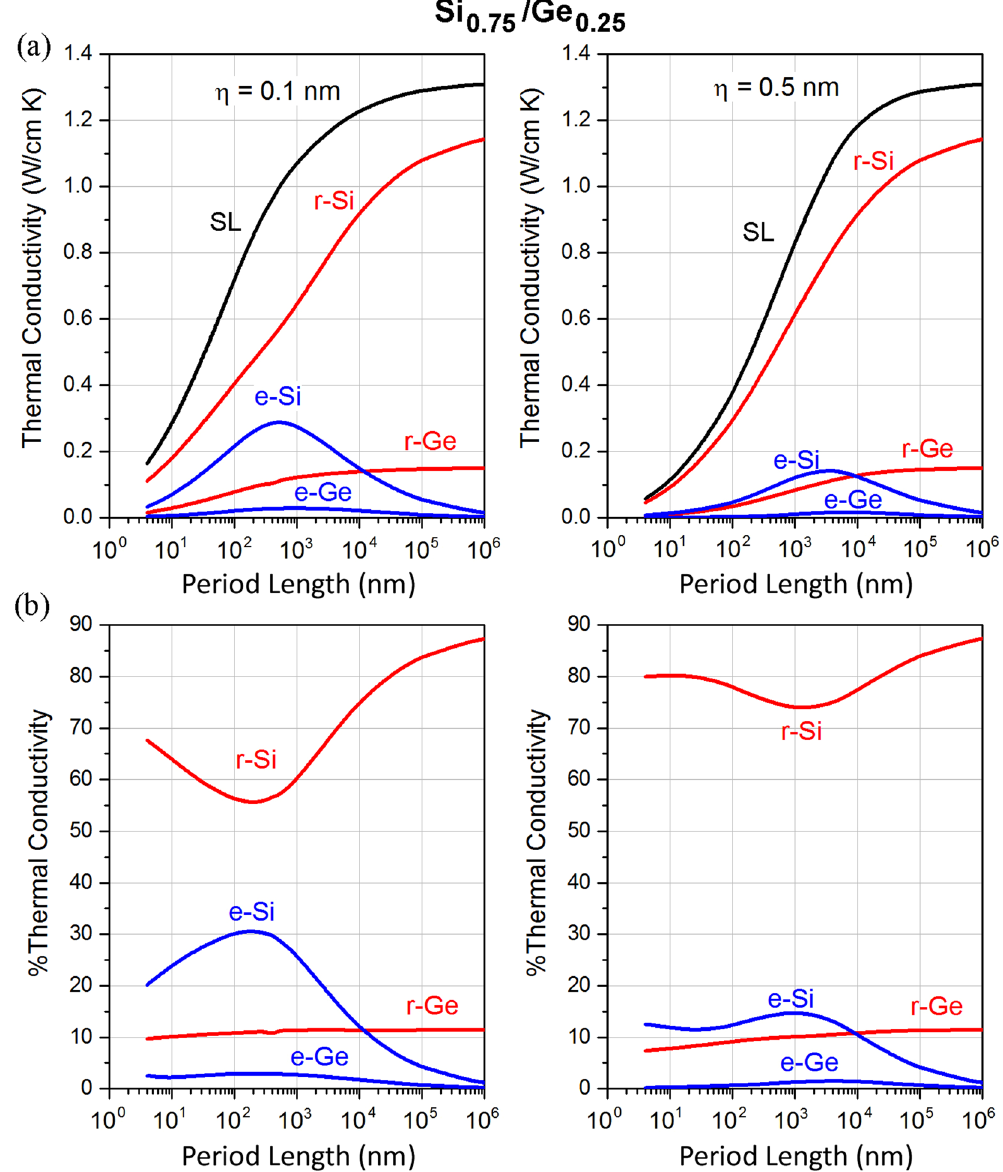
0.5 nm. ( b ) Relative contribution of extended and layer-restricted phonons in the corresponding